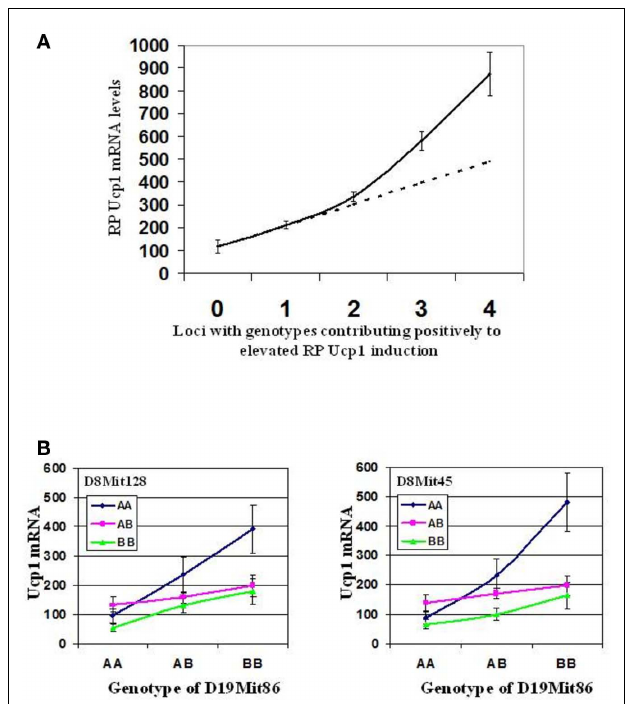
FIGURE 6 | (A) Synergistic effect of Iba QTLs on retroperitoneal Ucp 1 mRNA induction.This is a graphic representation demonstrating the complex epistatic and additive interactions between the four Iba loci.The solid line represents the experimental retroperitoneal fat (RP) Ucp 1 mRNA induction levels in relationship to the number of positive contributing loci. The dashed line indicates the theoretical value if interactions between Iba loci were only additive. (B) Effect of interactions between loci near Ucp 1 ( D 8 Mit 45, 40.5cM; D 8 Mit 128, 31cM), and D 19 Mit 86 (20cM) on retroperitoneal fat Ucp 1 mRNA induction in 286 intercross progeny from A × B10 and A × B8. Line interaction plots demonstrate a strong epistatic interaction between loci on chromosomes 8 and 19.This interaction appears to be stronger for D 8 Mit 45, a locus nearer to Ucp 1 than for D 8 Mit 128, the major QTL defined in the (A/J × B6) F1 × A/J backcross. Interaction plot data was generated using Statview v.4.5.